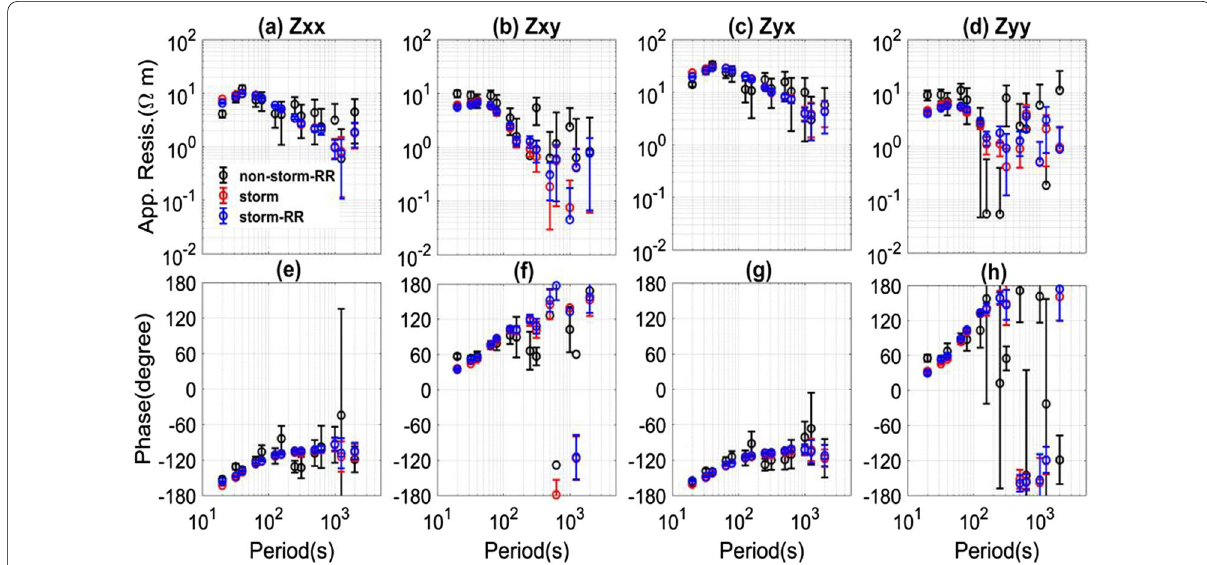
Fig. 12 Comparison of the MT sounding curves calculated by single-site and remote reference data processing using the storm and non-storm data observed at site 130. a – d Show the apparent resistivity. e – h Show the impedance phase. The horizontal axis denotes the period in seconds. The storm result and storm-RR result coincide and cover each other